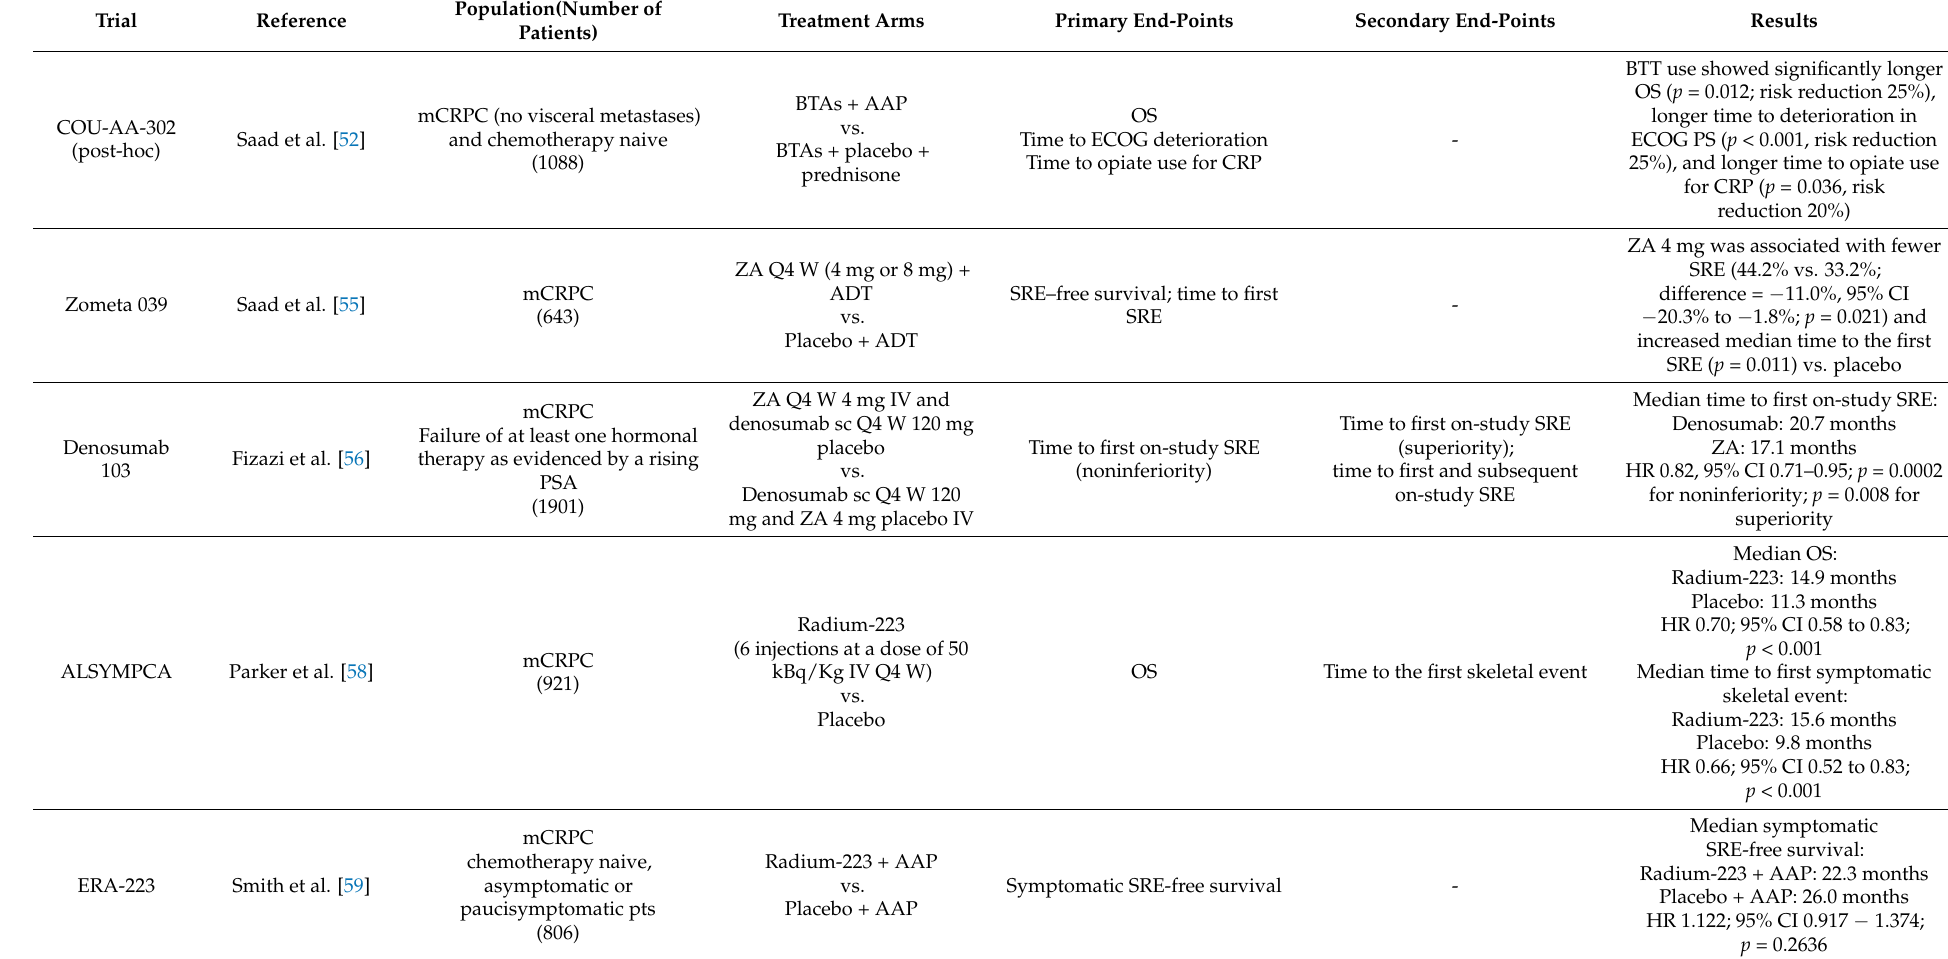
Table 2. Pivotal clinical trials investigating bone targeting agents in mCRPC